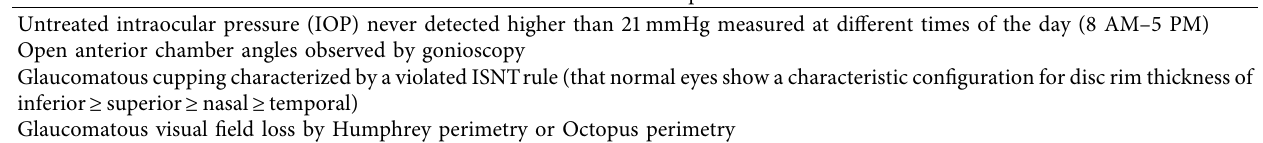
Figure 1: An overview of the inclusion of participants. A total of 12 patients with NTG were included, 10 of whom completed the study, in addition to 11 healthy controls. Excluded subjects did not meet the inclusion or did not want to participate. Table 2: Inclusion criteria for patients with NTG.